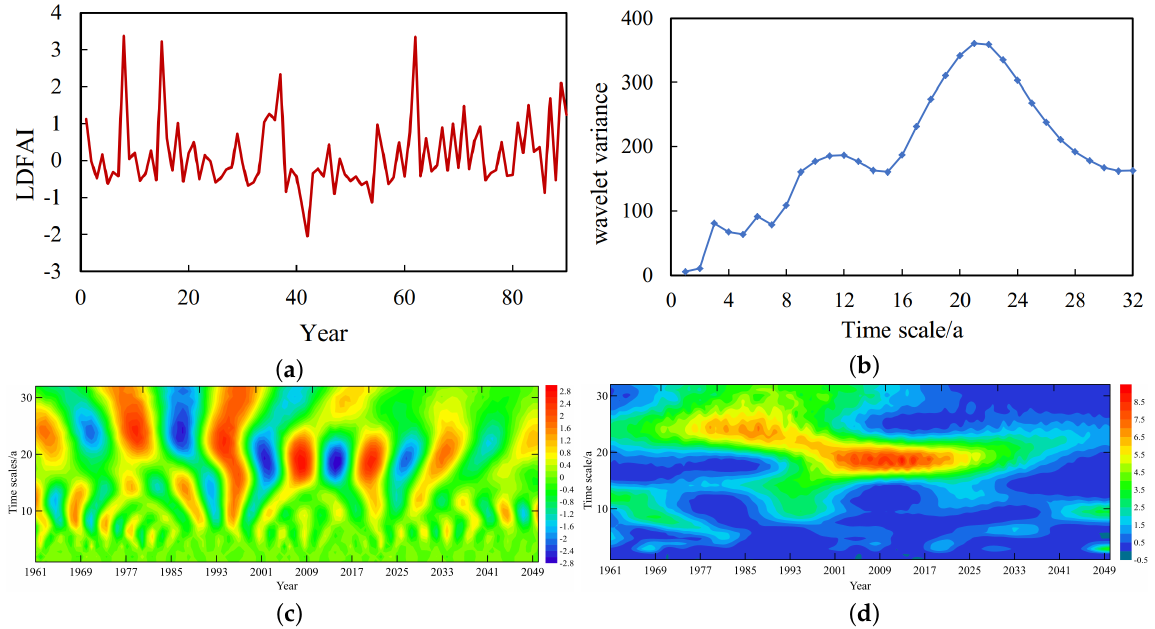
Figure 4. Morlet wavelet analysis of DFAA in the Hetao area during 1961 to 2050. ( a ) LDFAI; ( b ) Wavelet variance map; ( c ) Real part of wavelet transform coefficients; ( d ) Square of modulus of wavelet transform